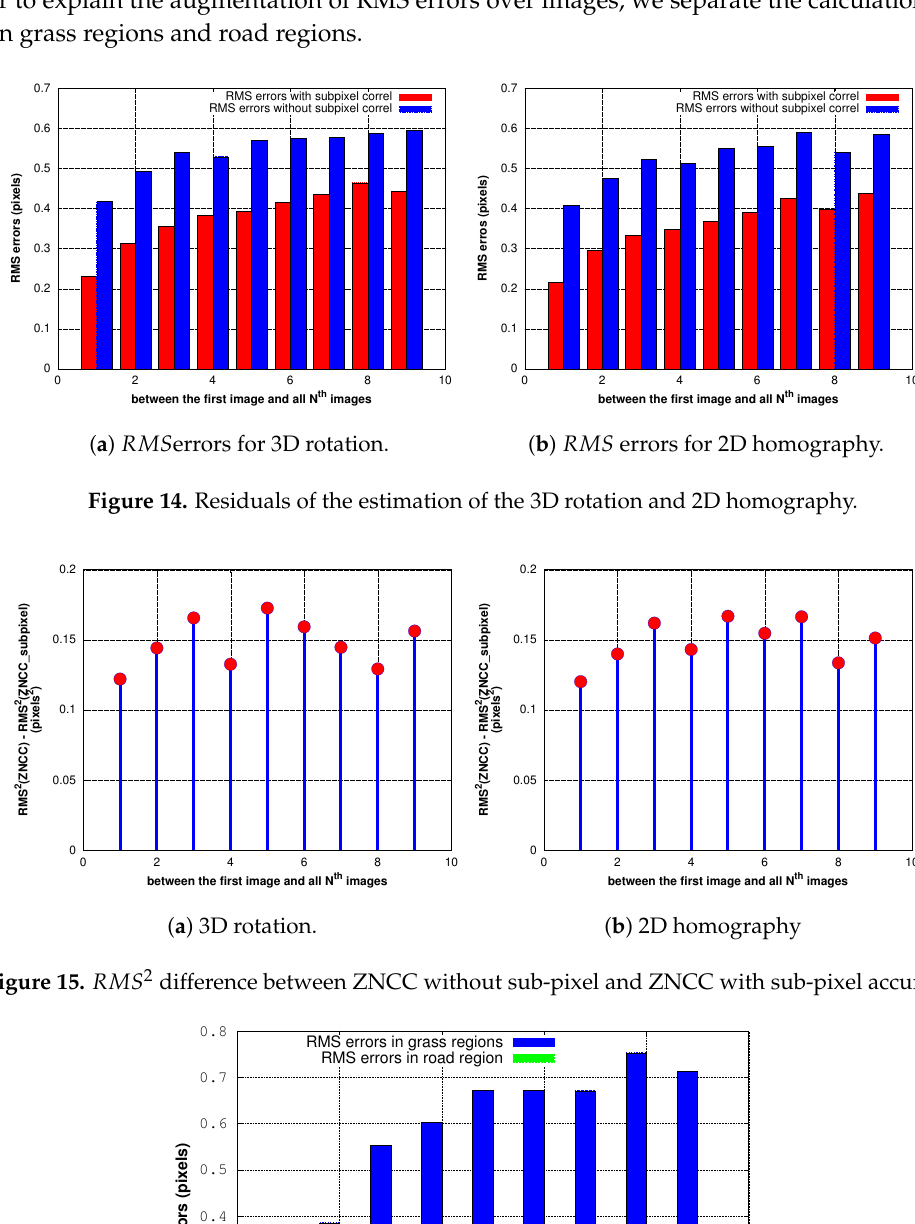
RMS errors with subpixel correl RMS errors without subpixel correl